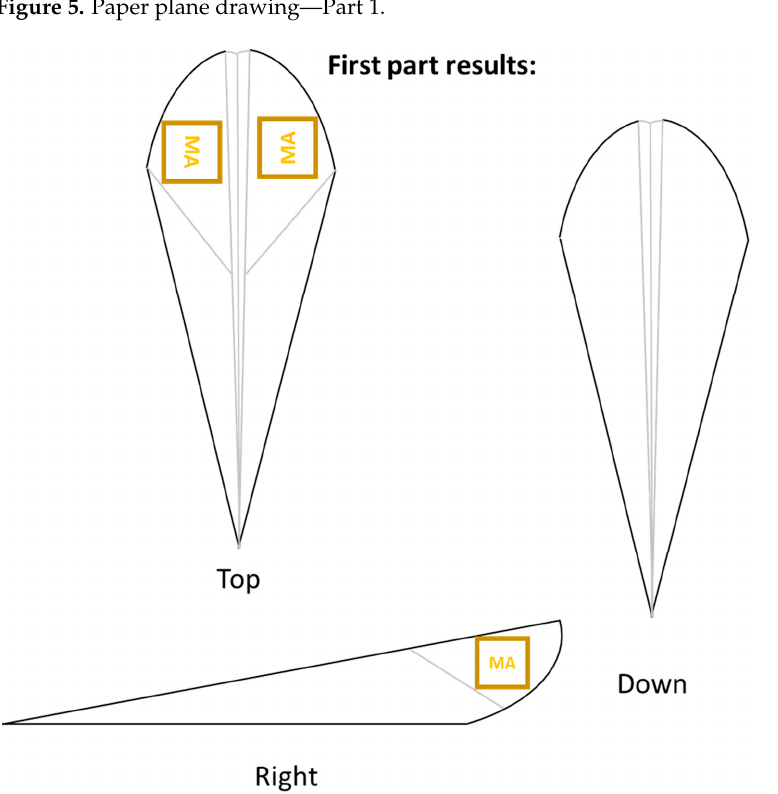
Figure 6. Paper plane drawing—Part 2.